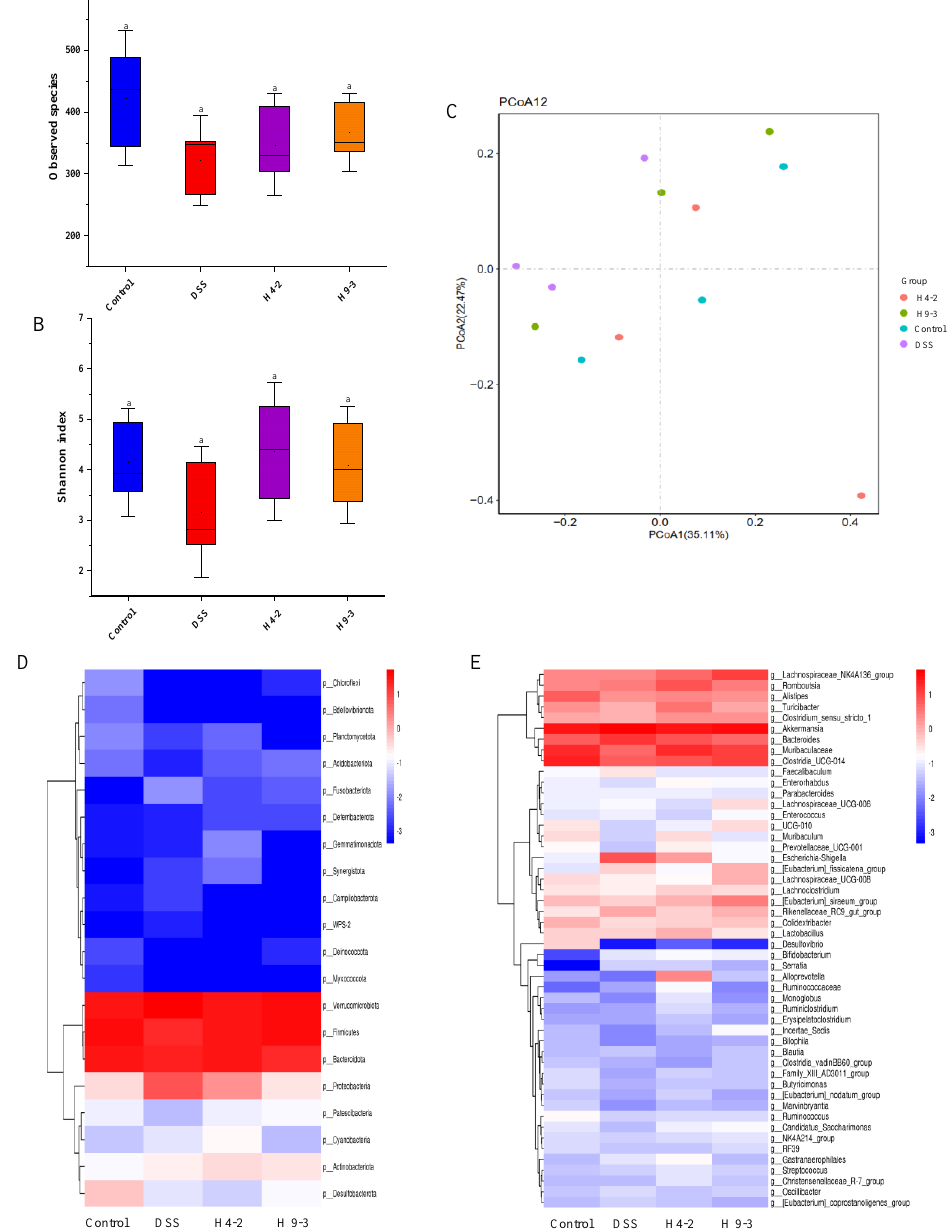
Figure 9. Changes of gut microbiota in mouse colon after intervention with B. breve . Comparison of the observed species ( A ), comparison of the Shannon index ( B ), PCoA analysis ( C ), phylum level ( D ), genus level ( E ). Different lowercase letters above the columns indicate significant differences ( p < 0.05), and the same superscript letters indicate that the differences between the values are not statistically significant ( p > 0.05).